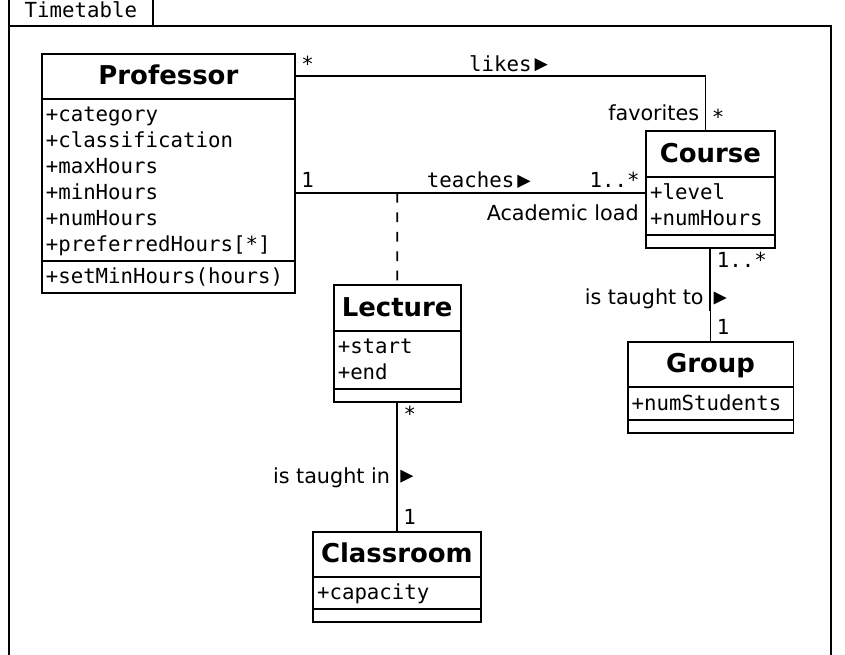
Figure 1. Unified Modeling Language (UML) domain